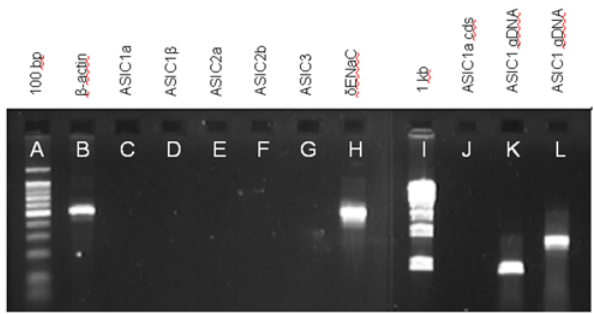
Figure 1. RT-PCR and genomic analysis of acid sensing ion channel (ASIC) gene expression for sour-ageusic Patient 8689. The patient expresses housekeeping and taste-related genes but ASIC transcripts are undetectable even after 50 cycles of amplification, and for ASICs 1a and 1 b this is not the result of a loss of the ASIC1 gene. Lane identifications: (A) 100 bp DNA marker with the brightest band being 500 bp; (B) Transcript of b -actin; (C–G) Transcripts of, respectively, ASICs 1a, 1 b , 2a, 2b and 3; (H) Transcript of d -ENaC; (I) 1 kb DNA marker; (J) ASIC1a, full coding sequence; (K) genomic DNA amplified with primer pair ASICMCF1 and ASICMCR1 (see Table 1); and (L) genomic DNA amplified with primer pair HASIC3 and HASIC4 (see Table 1). RT-PCR was performed with cDNA from fungiform papillae (B– H and J) , but only the data for the tubes containing reverse transcriptase are presented. No products were detected in the tubes lacking reverse transcriptase. Genomic analysis (K, L) was performed using buccal tissue. Individual amplification reactions were performed